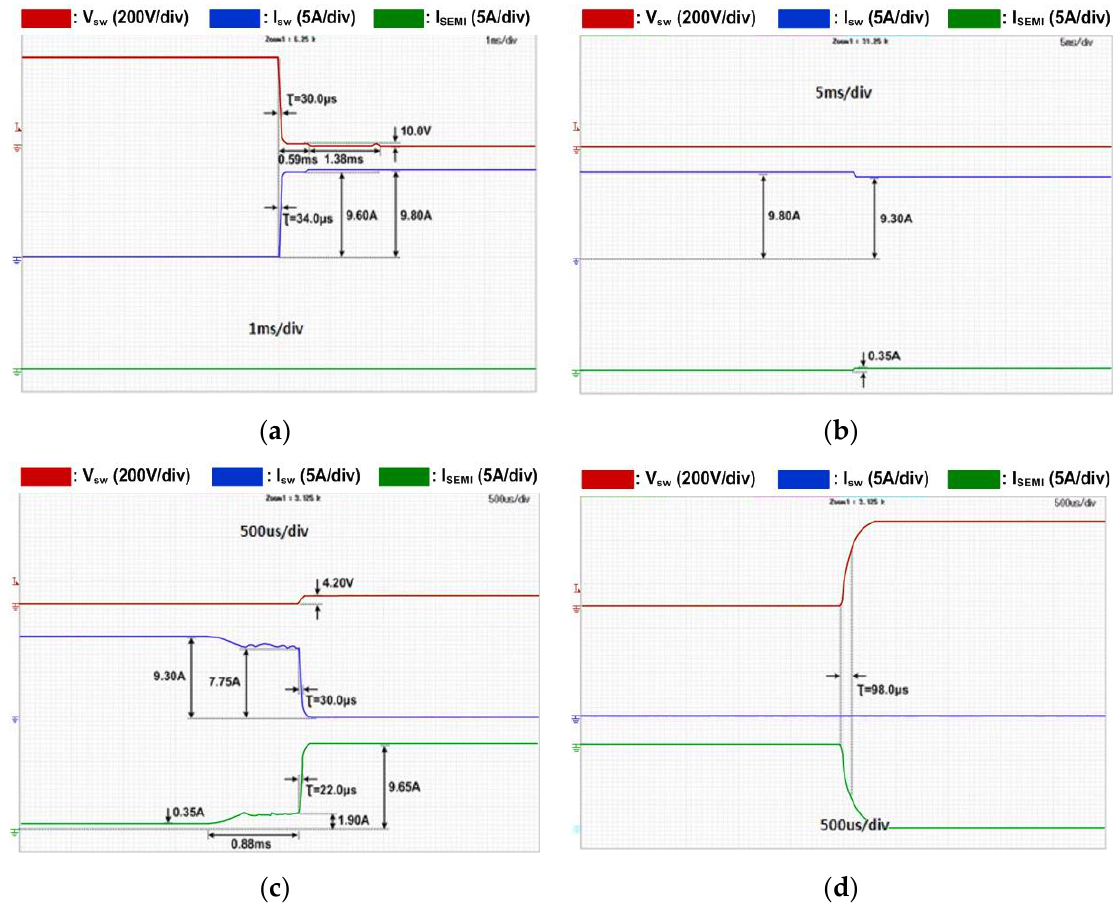
Figure 7. Experimental waveform of the proposed hybrid circuit breaker; ( a ) main switch ON, ( b ) semiconductor switch ON, ( c ) main switch OFF, ( d ) semiconductor switch OFF.